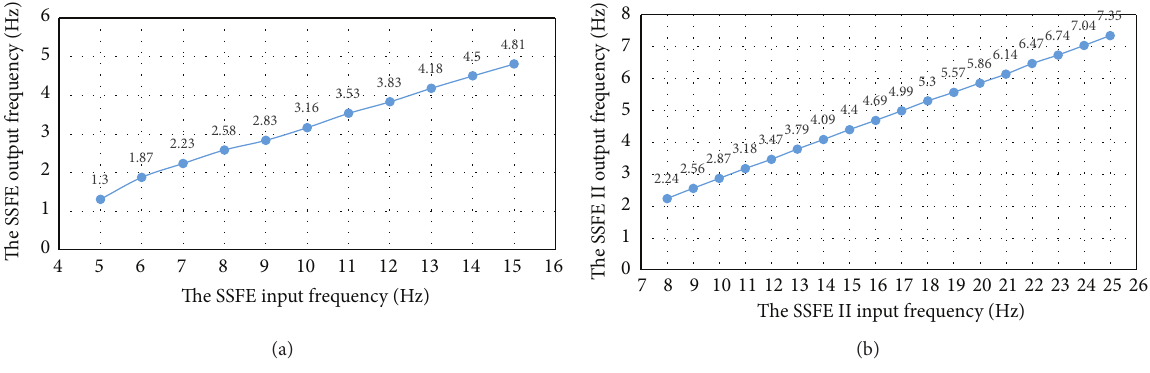
Figure 14: The SSFE and the SSFE II output frequency calibration curves. (a) The SSFE output frequency calibration curve. (b) The SSFE II output frequency calibration